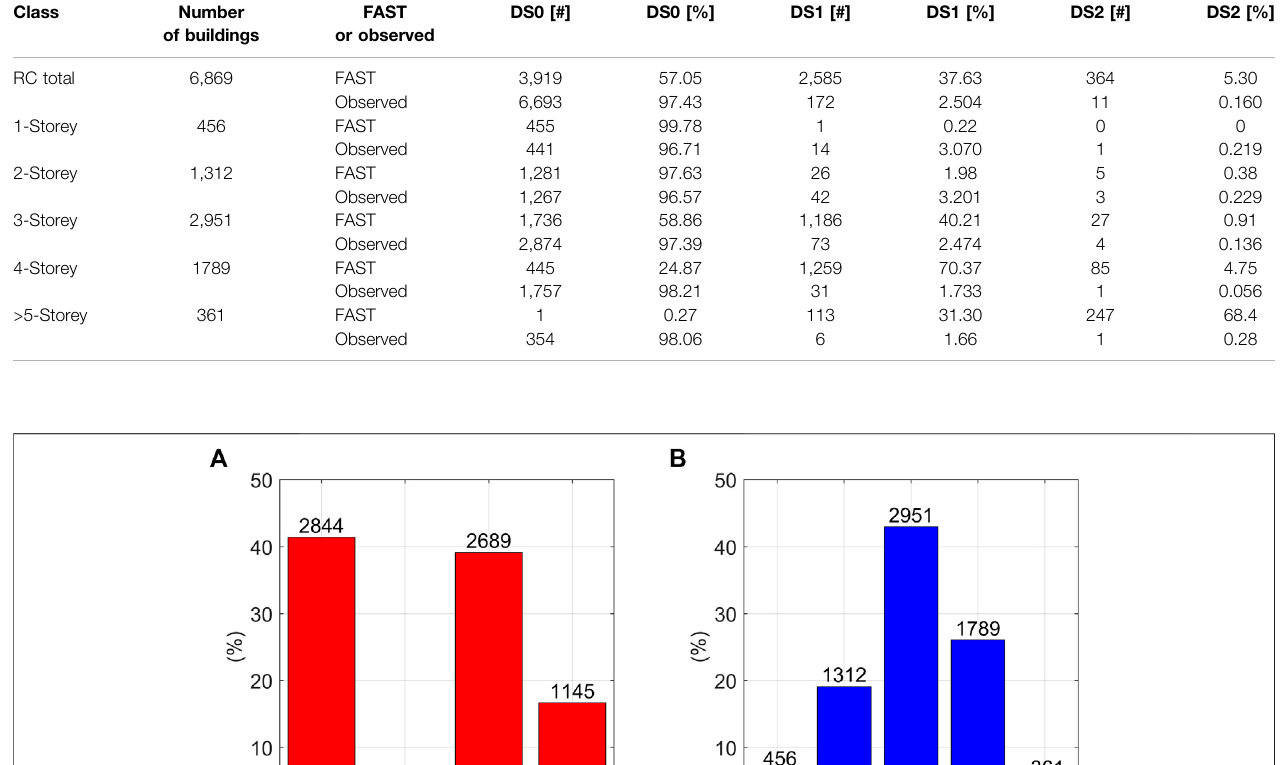
number of storeys ( Figure 11B ), and the presence of roof tanks ( Figure 11C ) that can affect the vulnerability of the structure signi fi cantly, as seen in many post-earthquake reports (e.g.,